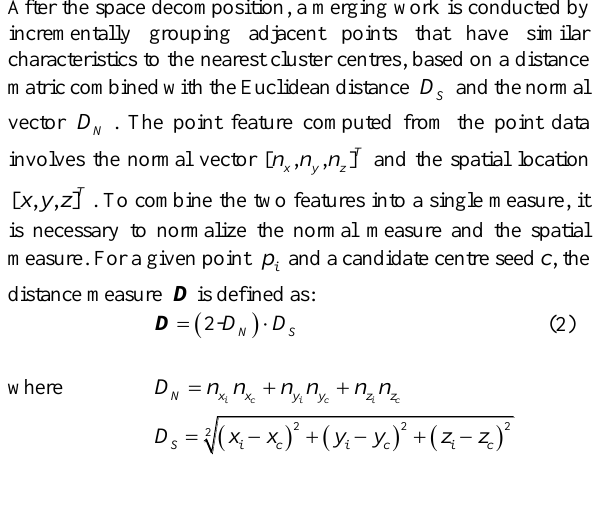
Figure 2. An example of the multi scale super voxels. (a) a point cloud with 3 ROIs, (b) the ROI points and their normal distributions, (c) the super voxel